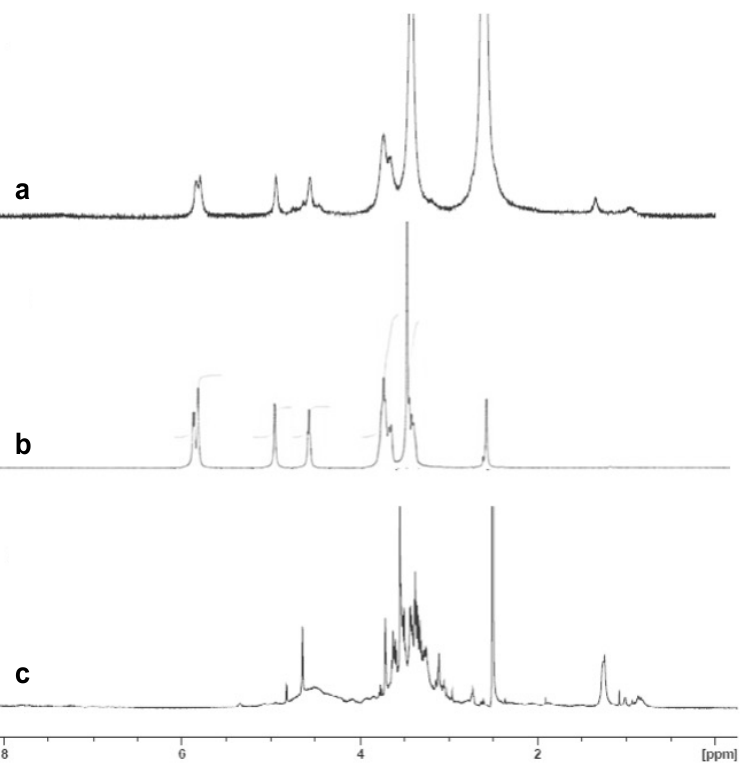
Figure 5. Comparison of the 1 H-NMR spectra in DMSO-d 6 of ( a ) PCE encapsulated in β CD, ( b ) β CD and ( c ) PCE.